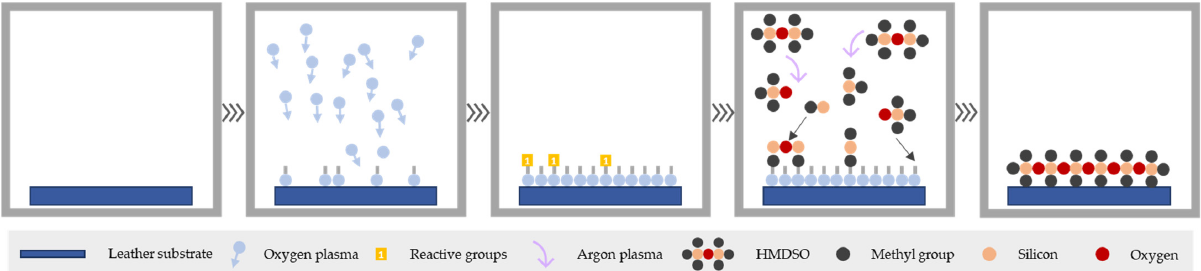
Figure 1. Surface activation and plasma polymerisation phases of the treatment. Samples with and without plasma treatment will be referenced as “plasma coated leather” and “untreated leather”,